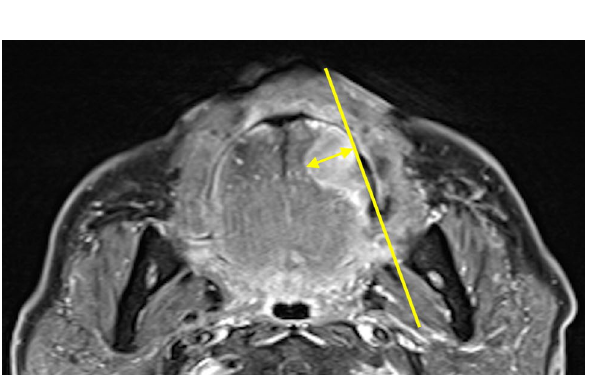
and the deepest point of tumor was determined. r-DOI radiological depth of invasion.